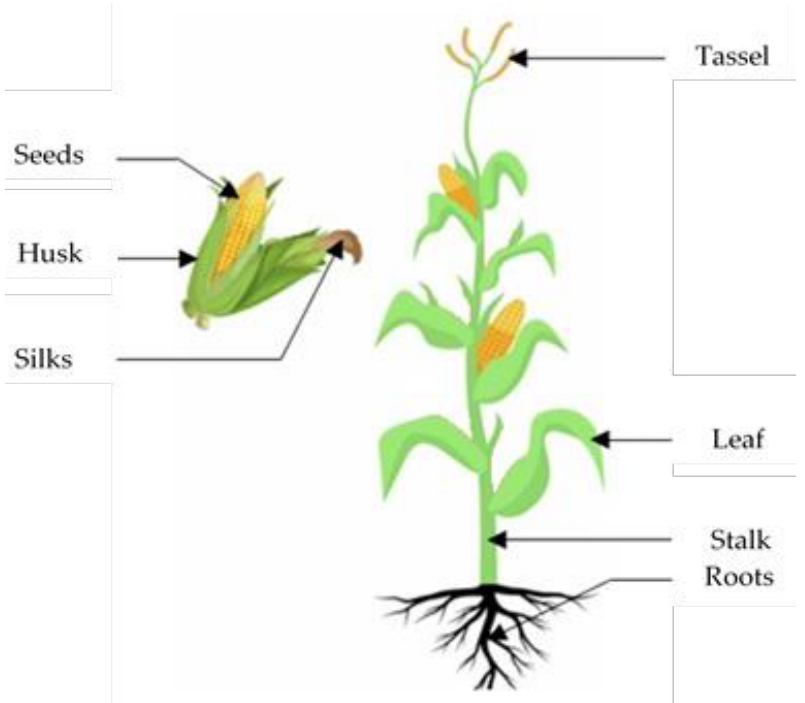
Figure 2. Different parts of corn plant.